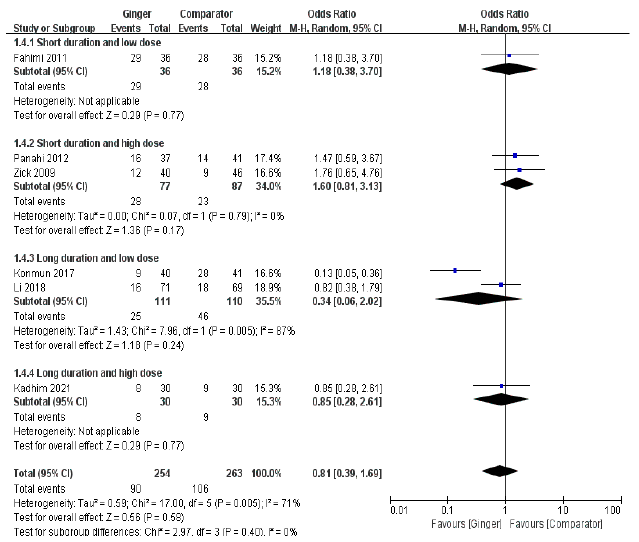
Figure 5. Effects of ginger intake on chemotherapy-induced delayed vomiting. Short duration ≤ 4 days; Long duration > 4 days; Low dose ≤ 1 g/day; High dose > 1 g/day. Fahimi 2011 [19], Panahi